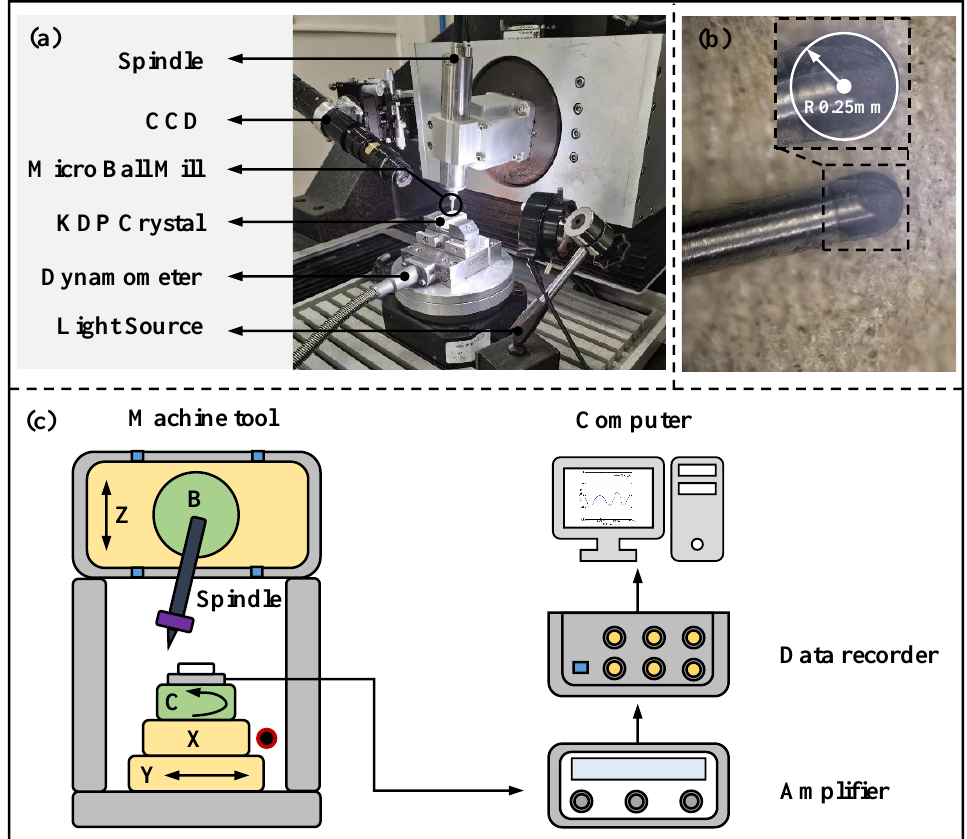
Figure 2. The schematic of the micro-milling device: ( a ) experimental device for micro-milling KDP crystals; ( b ) the geometry of the ball-end milling cutter; ( c ) the experimental setup for measurement of cutting force.